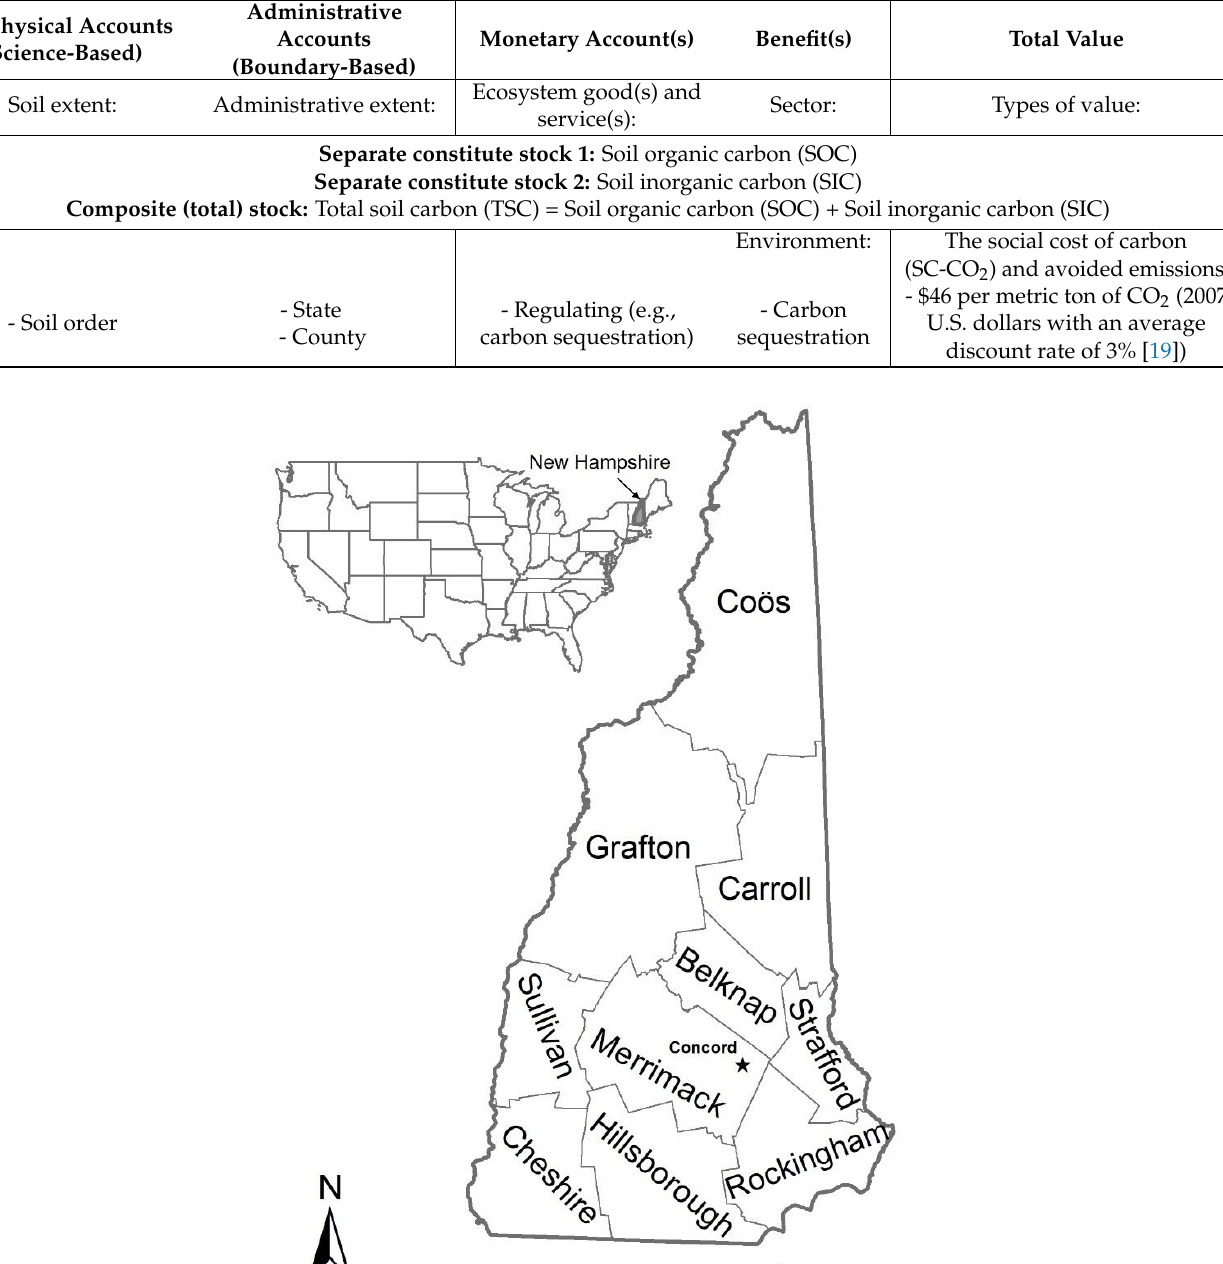
Table 3. Soil diversity (pedodiversity) by soil order (taxonomic pedodiversity) and county in New